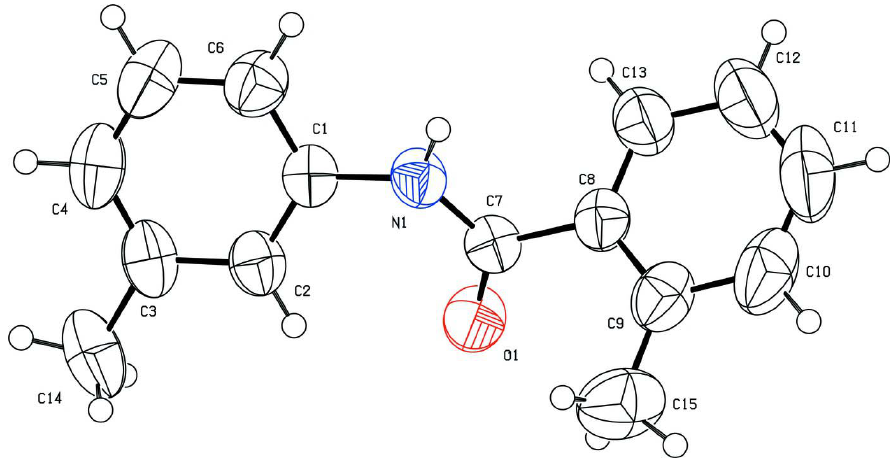
Figure 1 Molecular structure of the title compound, showing the atom labeling scheme. The displacement ellipsoids are drawn at the 50% probability level.